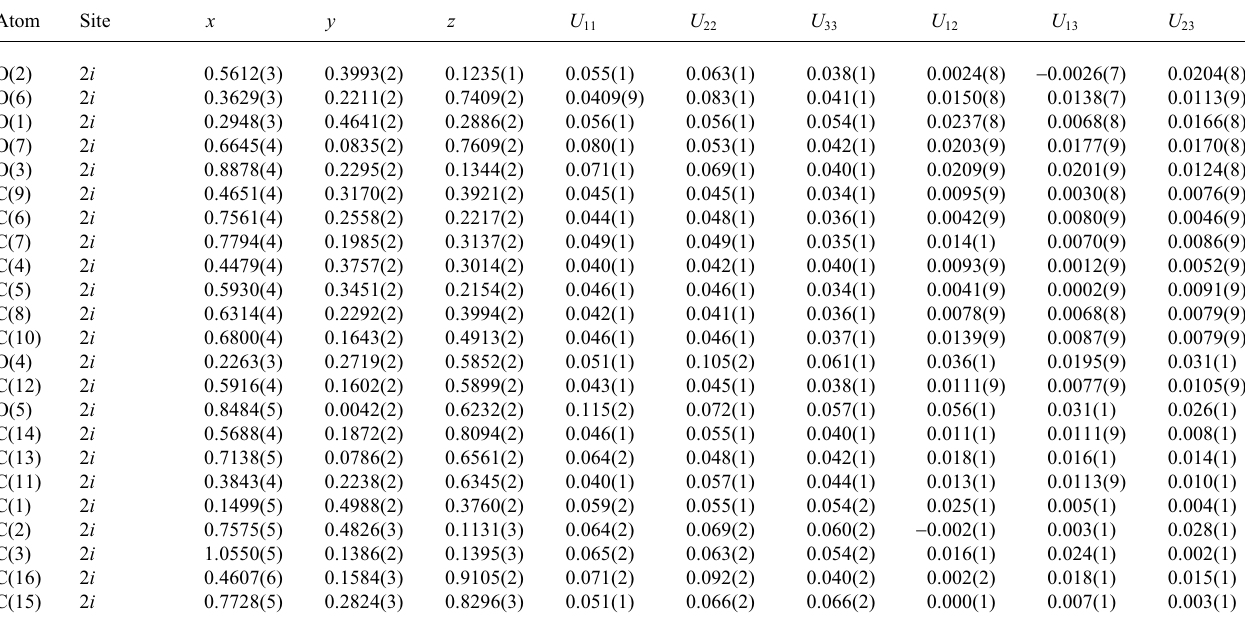
Table 3. Atomic coordinates and displacement parameters (in Å 2 )